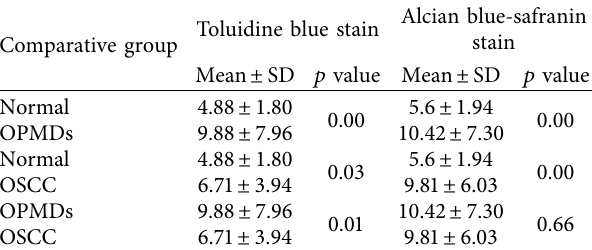
Figure 1: Toluidine blue (a) and Alcian blue-safranin (b) staining of mast cells in OSCC (40x). Table 2: Intergroup comparison of mast cell using toluidine blue and Alcian blue-safranin stain.